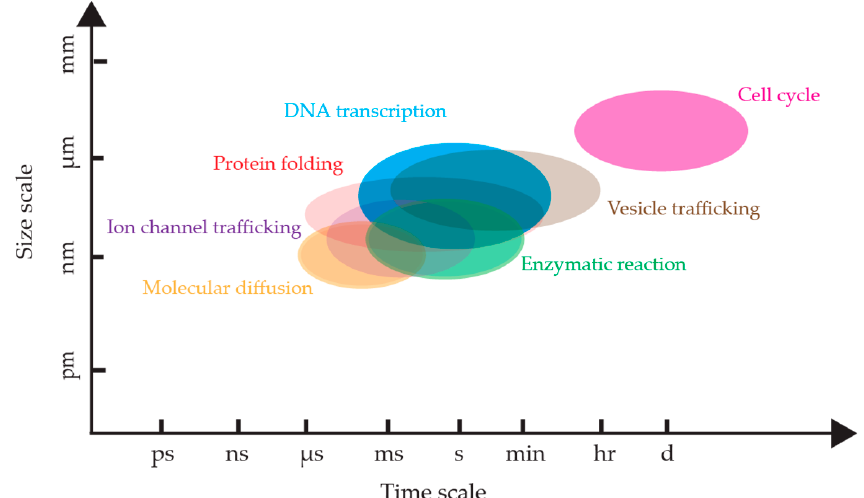
Figure 1. The temporal and spatial scales of biological processes. The time windows and size windows are approximate, and each process has its own situation-dependent scale. References: DNA transcription rate [29], protein folding [30–32], molecular di ff usion [33–35], cell cycle [36],